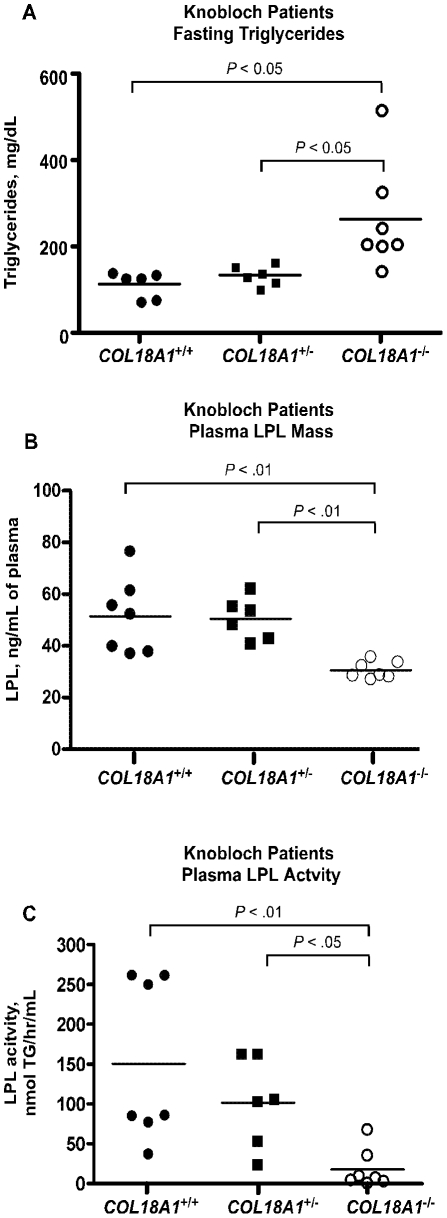
Hypertriglyceridemia in Knobloch patients.(A) Plasma triglycerides were measured in blood samples collected from patients with Knobloch syndrome (COL18A1−/−) (open circles, n = 7), heterozygous carriers (COL18A1+/−, closed squares, n = 6) and normal control subjects (COL18A1+/+, closed circles, n = 6). Plasma triglycerides differed by group (P = 0.011) and the difference between Knobloch and normals was significant (P<0.05) (B) Plasma Lpl levels were measured by sandwich ELISA in previously frozen heparinized plasma collected from fasting subjects with Knobloch syndrome (open circles), heterozygous carriers (closed squares) and normal control family members (closed circles). Plasma Lpl levels differed by group (P = 0.001) and Knobloch levels were reduced compared to heterozygotes (P<0.01) and unaffected family members (P<0.01) (C) Activities levels of Lpl were measured according to the assay described in Methods and converted to units of (nanomoles) triglyceride hydrolyzed per hour per ml plasma. Knobloch plasma contained reduced Lpl activity compared to heterozygous carriers (P<0.05) and normal family members (P<0.01).